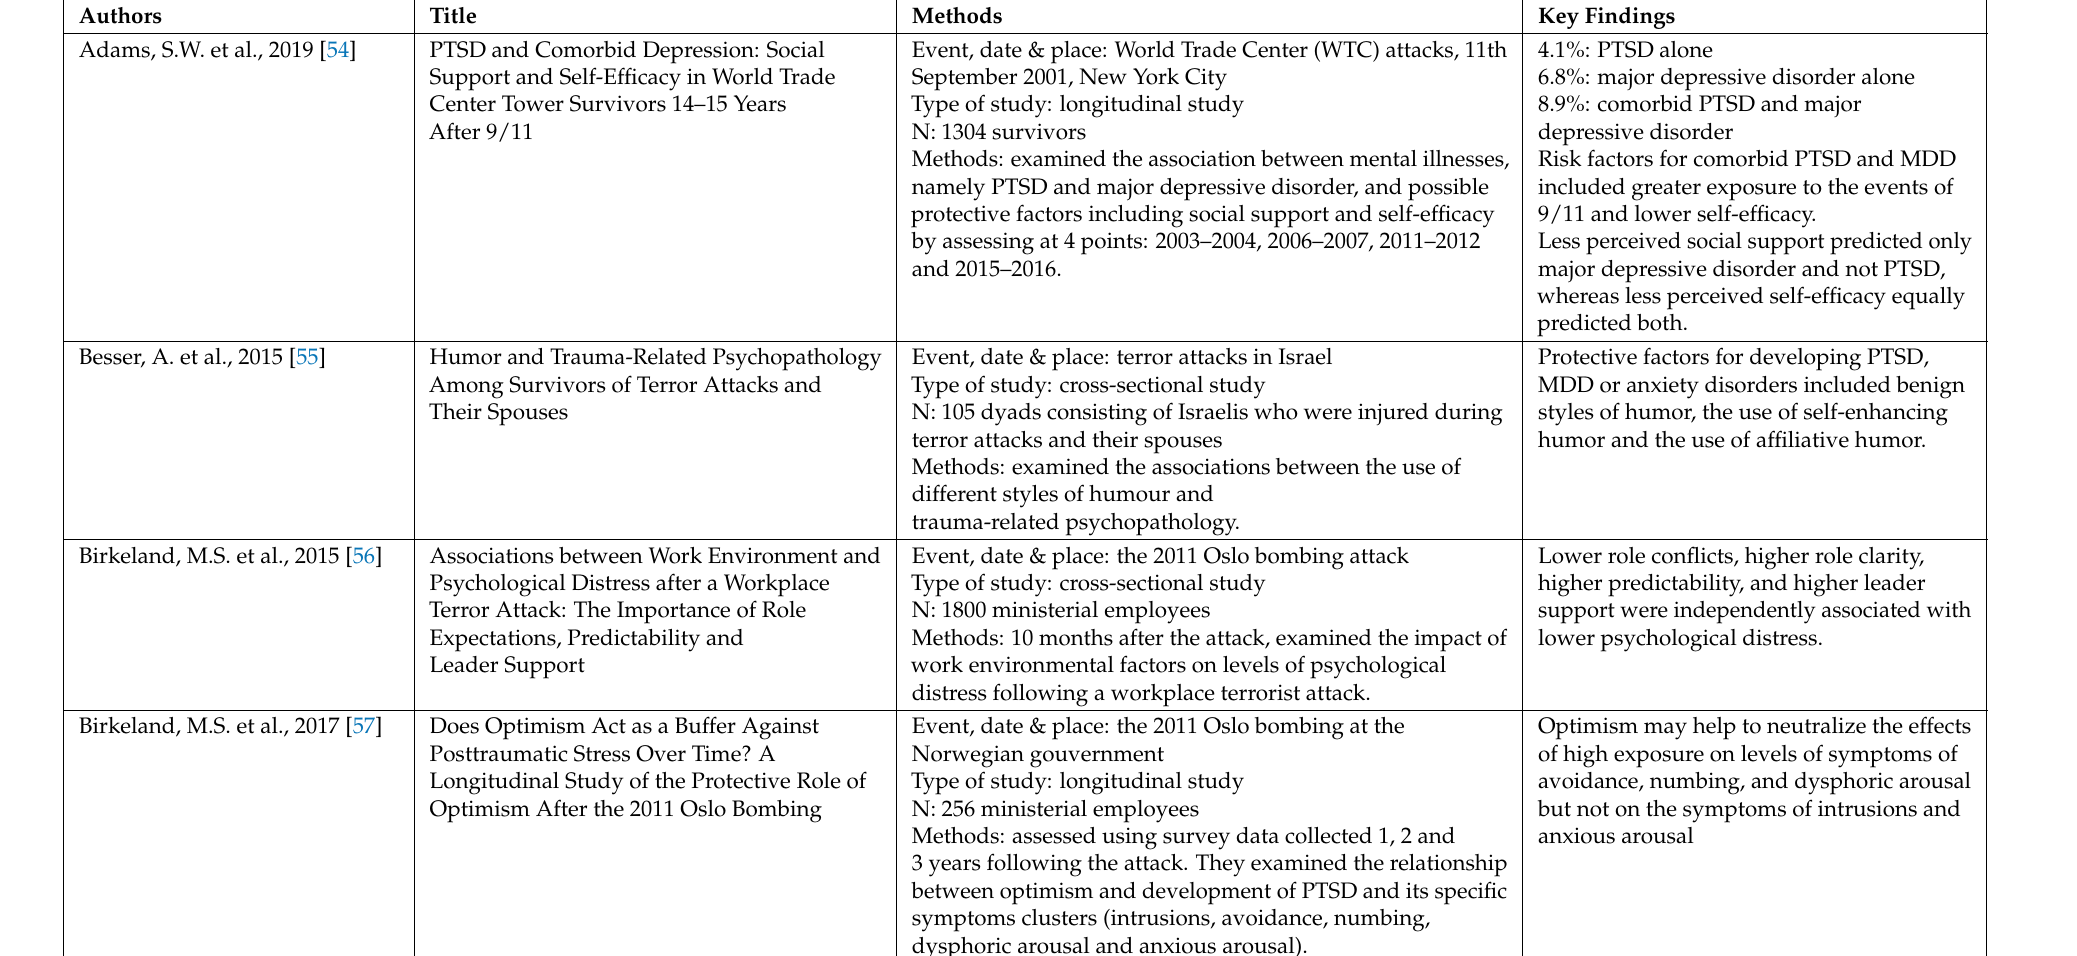
Table 3. Preventative and vulnerability factors against development of mental disorders after terrorist